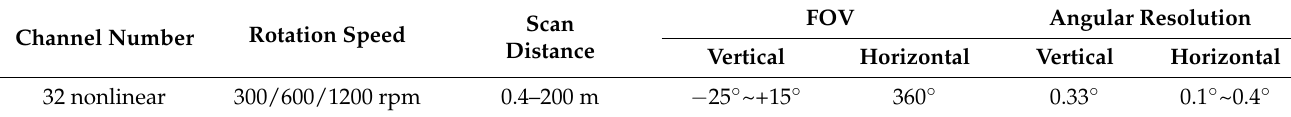
Table 5. RS-LiDAR-32 specifications.